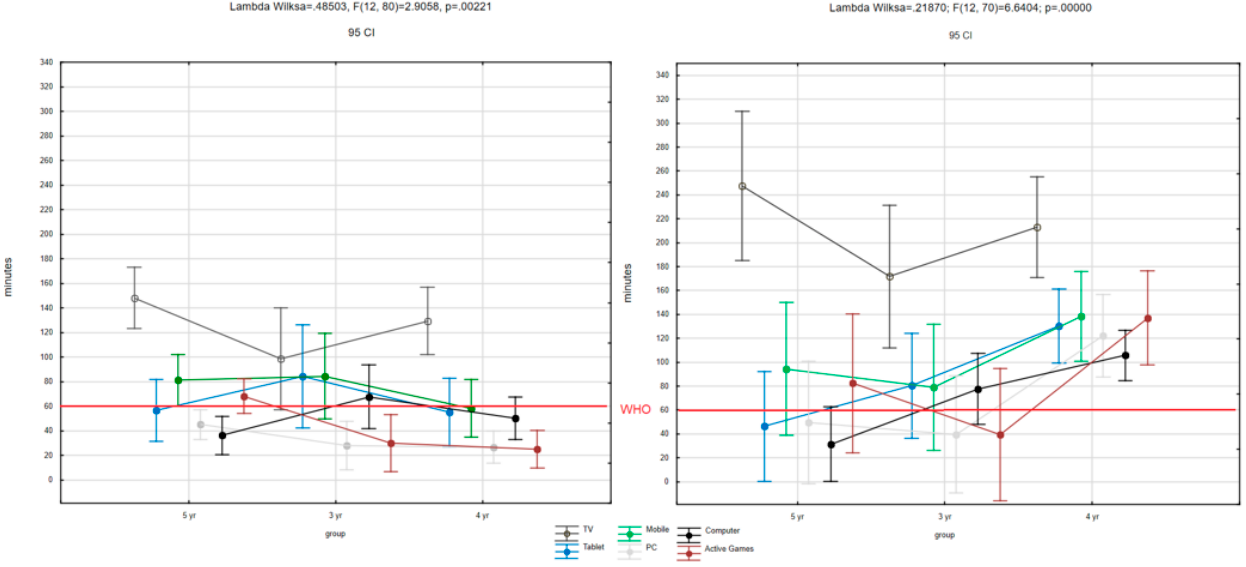
Figure 4. Average values of time spent using different electronic devices in groups of children aged 3–5 years (see before pandemic on the left side and during pandemic on the right side). Red line is the maximum time limit recommended by WHO for this age group.